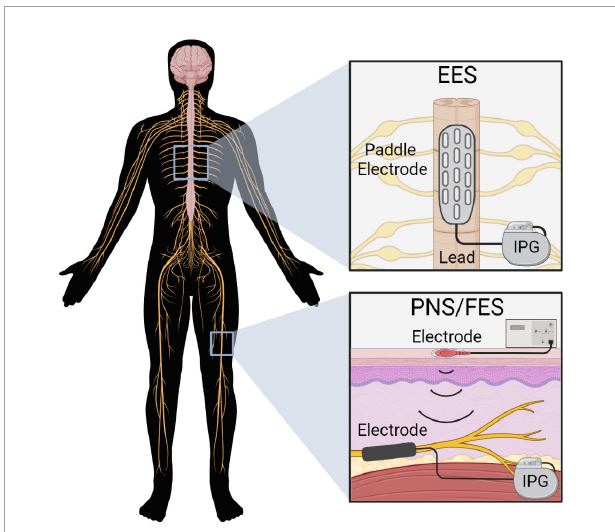
FIGURE2 Electrical stimulation devices commonly used post-SCI. EES delivers stimulation over the spinal cord via a paddle electrode array that receives power from an implanted pulse generator (IPG). PNS and FES deliver stimulation to the target nerve via implanted electrodes connected to an IPG, or via percutaneous or transcutaneous